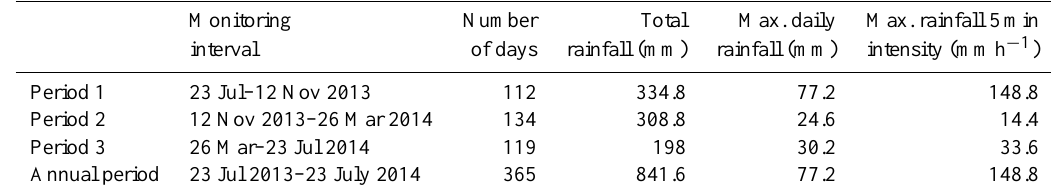
Table 1. Summary of time intervals and rainfall data recorded during the monitoring periods.